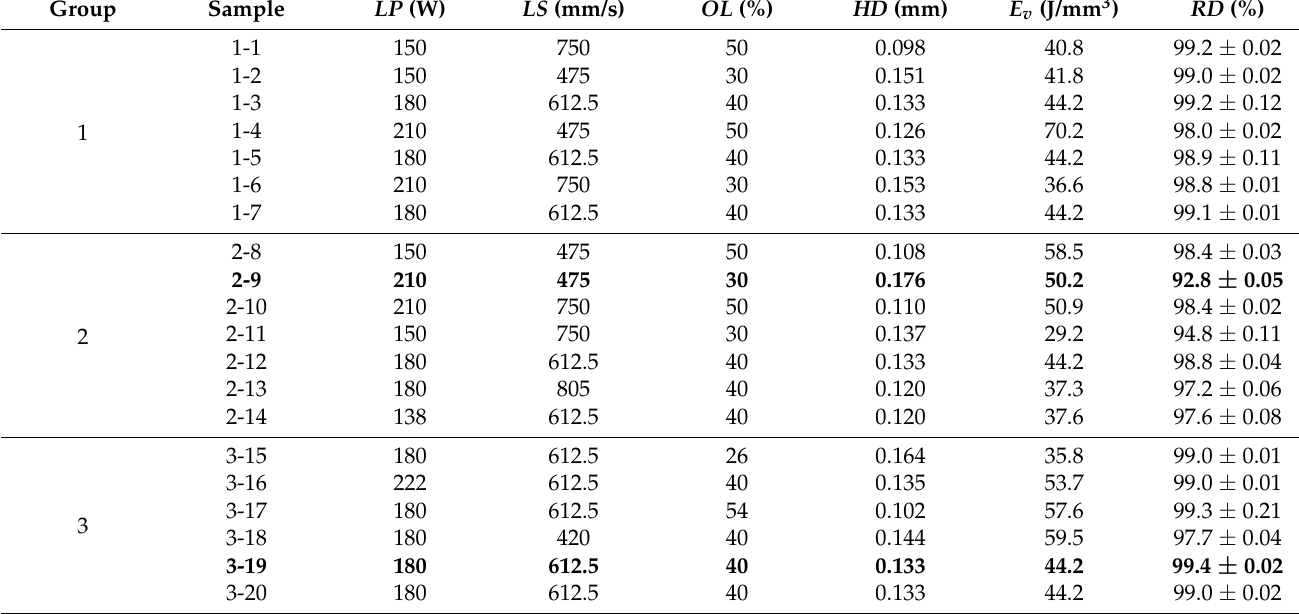
Table 3. Overview of process parameters and measured values of area relative density ( RD ) of cube samples with standard deviation, XY